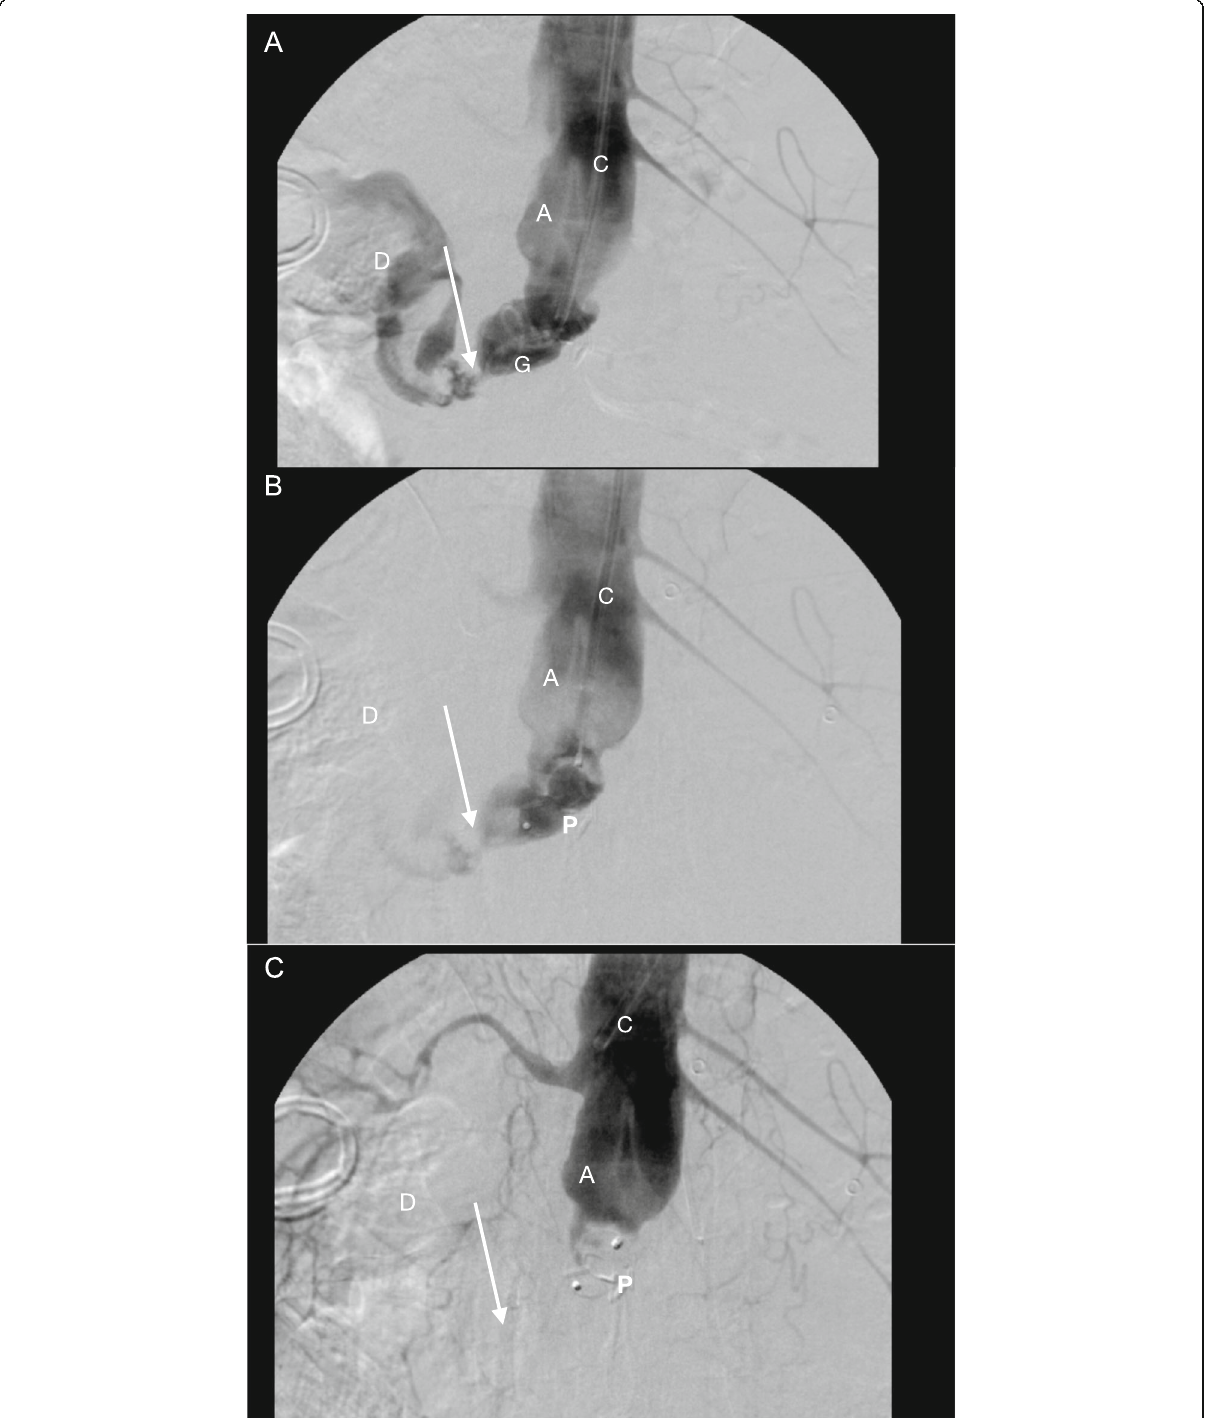
Fig. 2 Angiography and the placement of the Amplatzer® Vascular Plug in the aortic stump. Angiography via the axillo-bi-femoral bypass demonstrating the infrarenal aortic stump ( a ), the duodenum ( d ) and the ADF marked with the arrow ( ↓ ). The angiographic catheter is marked with C and the guide wire with G. The upper graph ( a ) demonstrates contrast passage from the aorta through the ADF towards the duodenum. The middle graph ( b ) was taken 5 min following release of a 16-mm Amplatzer® Vascular Plug (P) within the aortic stump, and demonstrates minor contrast passage from the aortic stump towards the duodenal loop. The lower graph ( c ), 23 min later, demonstrates successful closure of the aortic stump with no further contrast leakage through the